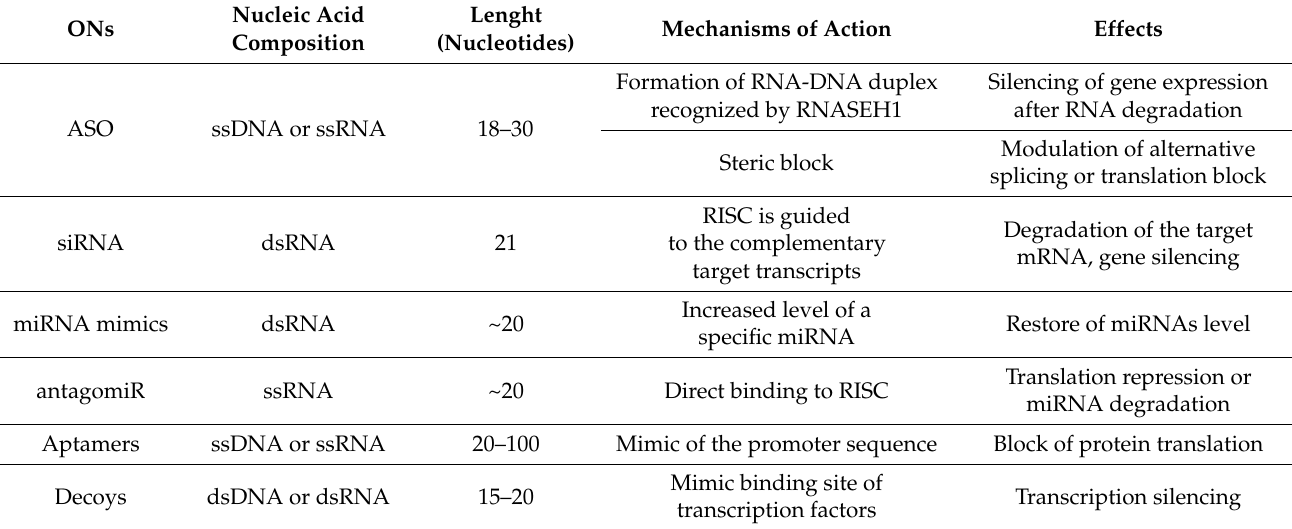
Table 1. Therapeutic oligonucleotides (ONs). ASO: antisense oligonucleotides; DNA: deoxyribonucleic acid; RNA: ribonucleic acid; ssDNA: single strand DNA; dsDNA: double strand DNA; ssRNA: single strand RNA; dsRNA: double strand RNA; siRNA: small interfering RNA; RISC: RNA induced silencing complex; mRNA: messenger RNA; miRNA: microRNA; antagomiR: